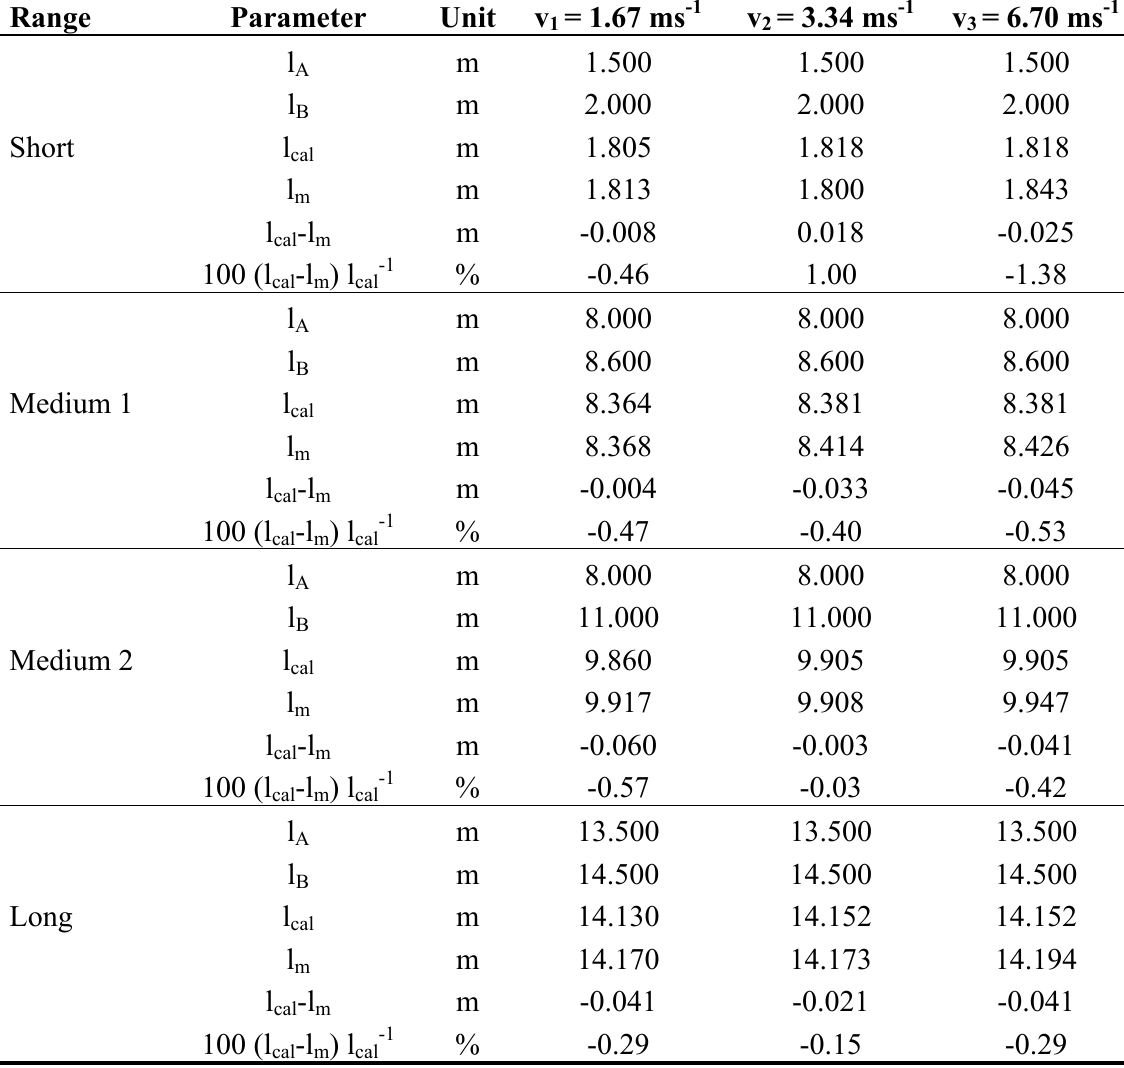
Table 4. Absolute and relative deviations of range readings from calculated value for two reflection levels and three circumferential speeds (see Figure